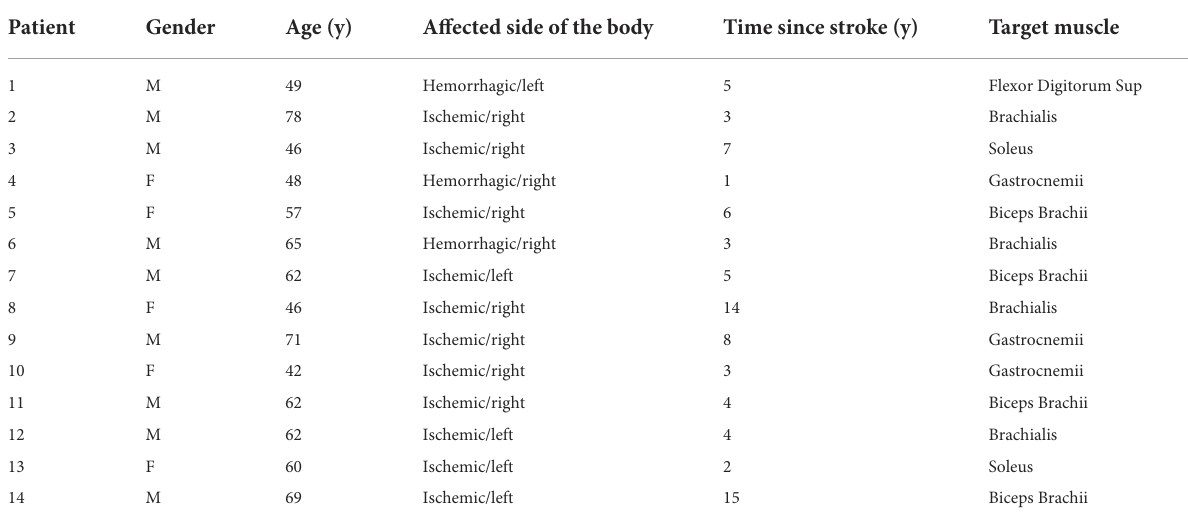
TABLE 1 Baseline patients’ characteristics and assessed